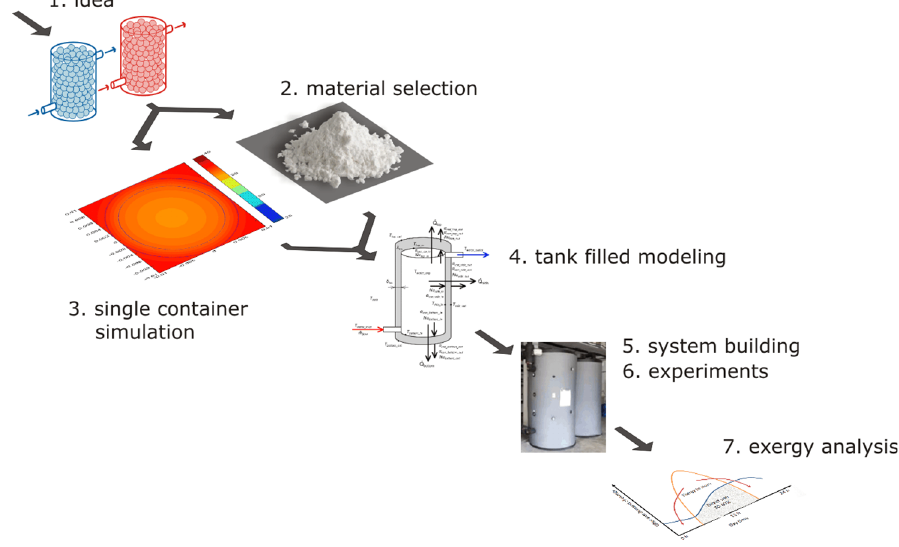
Figure 1. Stages, where 1—concept, 2—material selection, 3—single capsule simulations, 4—tank modeling with material, 5—system construction, 6—experimental research, 7—exergy analysis.